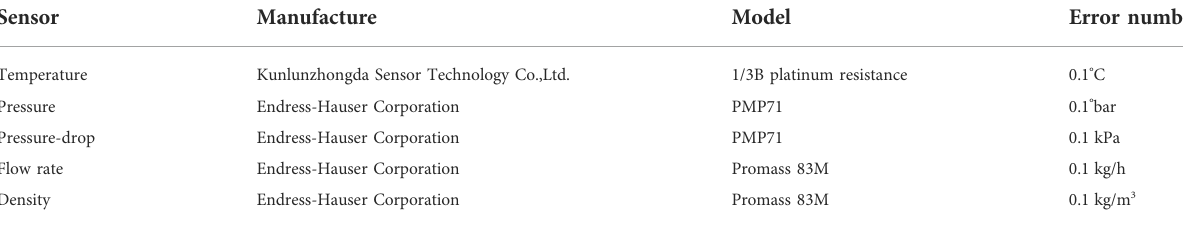
TABLE 2 Model and error numbers of temperature, pressure, pressure-drop, fl ow rate, and density sensors.